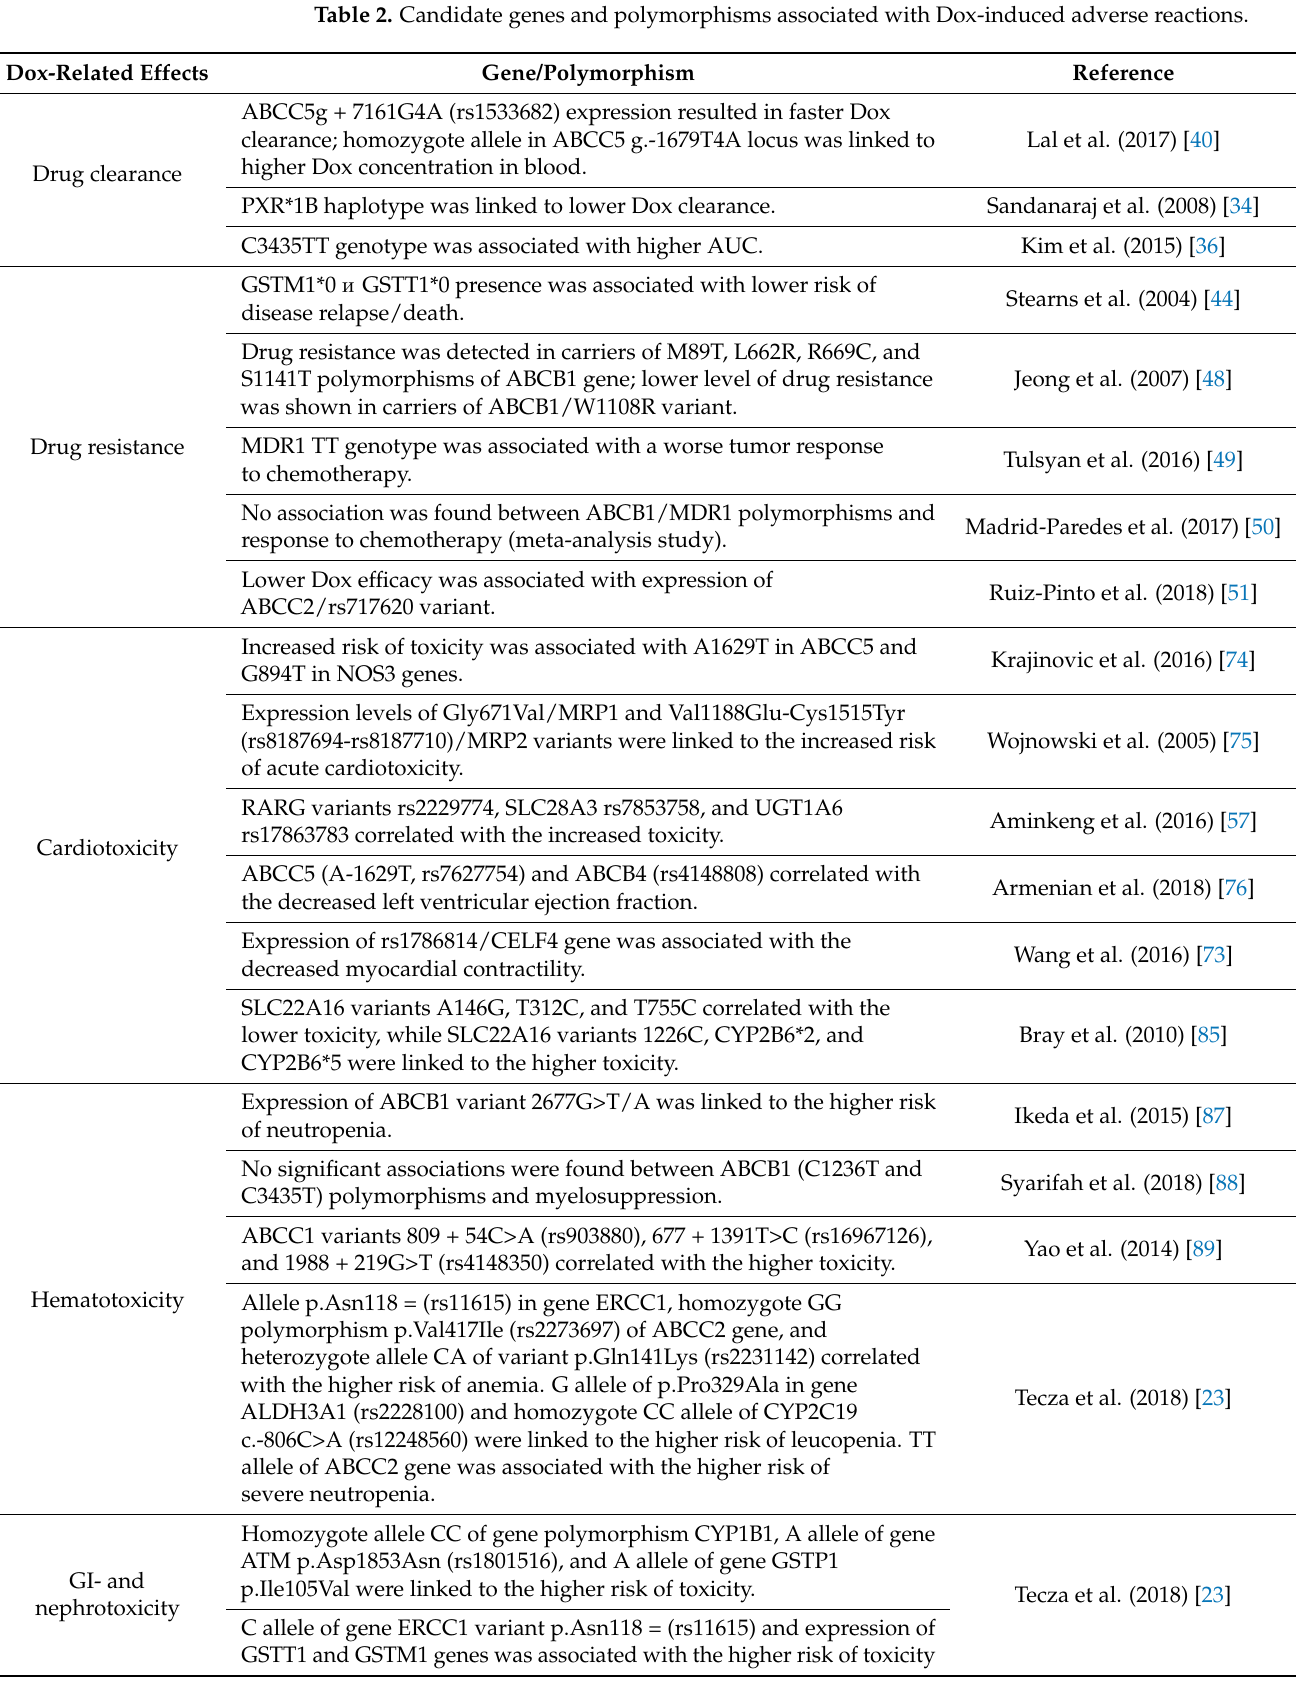
Table 2. Candidate genes and polymorphisms associated with Dox-induced adverse